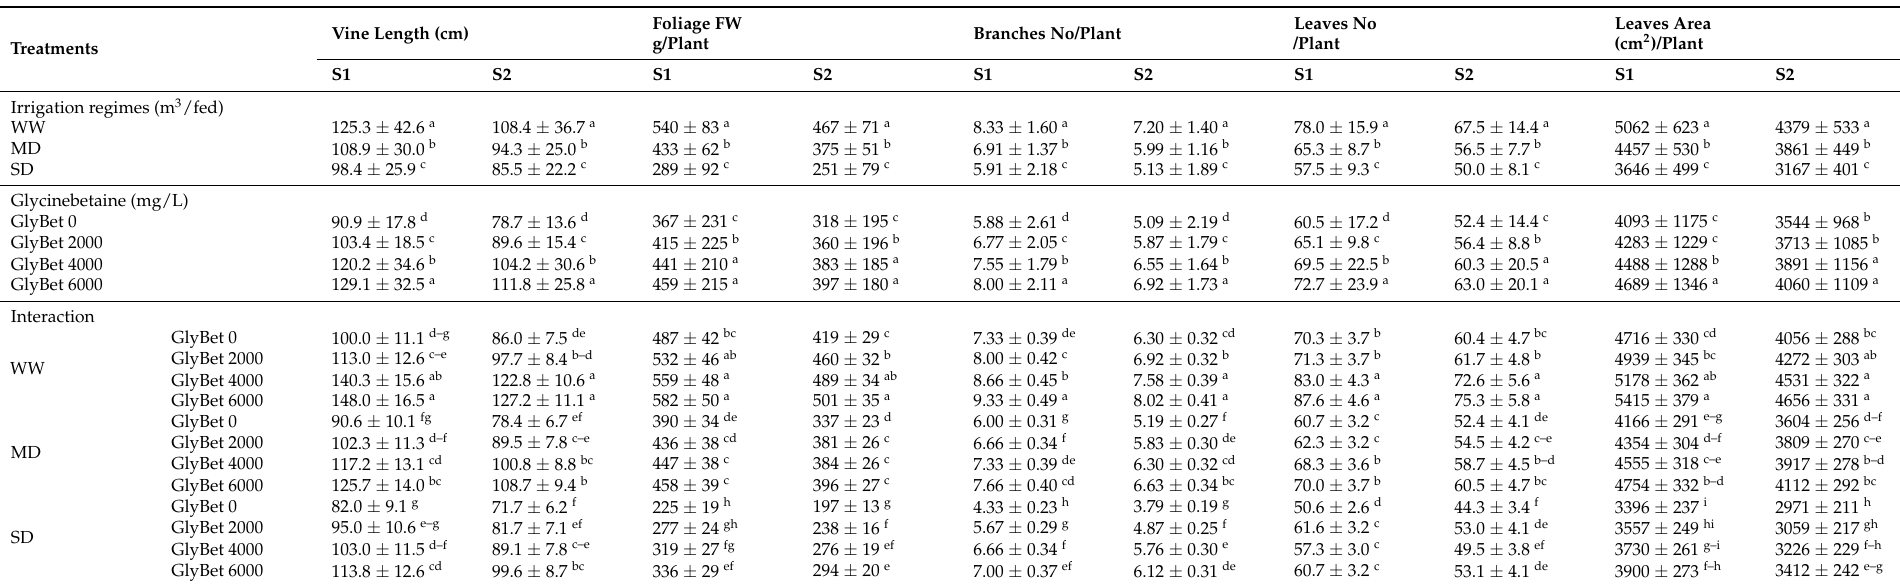
Table 2. Cucumber plant growth as affected by GlyBet concentration, irrigation regimes, and their interactions at 35 days from sowing in both seasons 2020 and